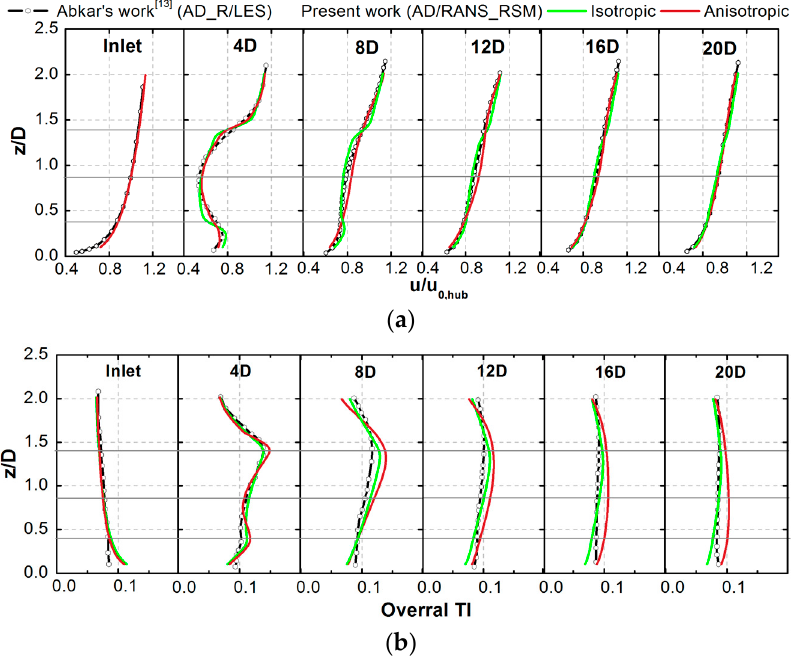
Figure 6. Vertical profiles of ( a ) wake velocity and ( b ) overall TI for the downstream locations of 4 D , 8 D , 12 D , 16 D , and 20 D . The horizontal gray lines represent top tip, hub height, and bottom tip heights.